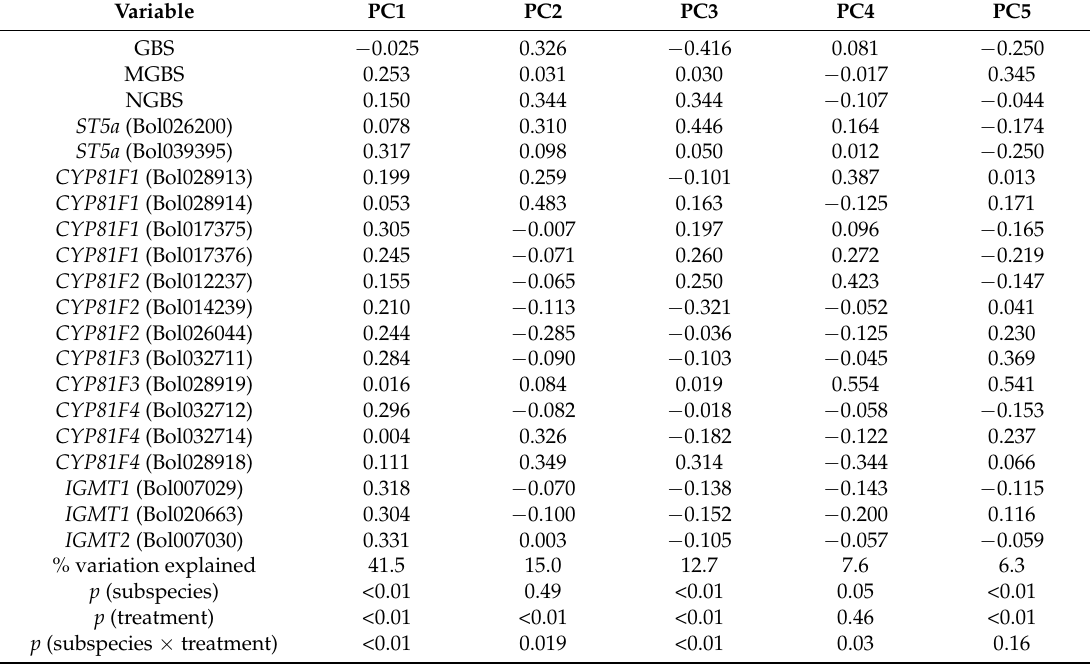
Table 2. Principal component analysis for indolic glucosinolate contents and relative expression of genes in three subspecies of B. oleracea in control, MeJA-treated and SA-treated plants. PC, principal component; p , statistical